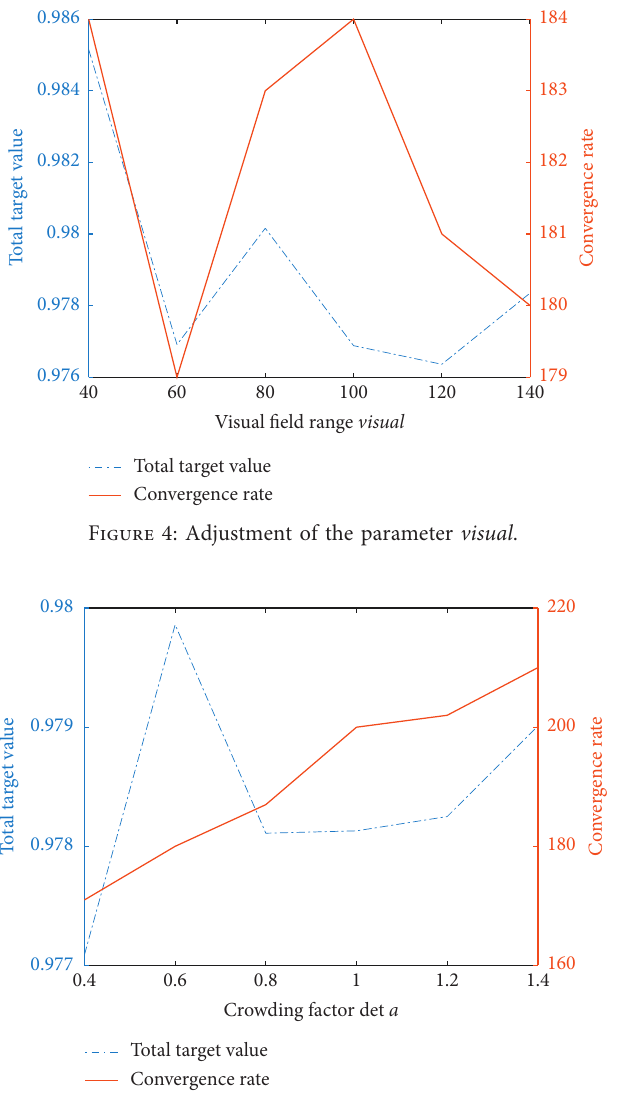
Figure 5: Adjustment of the parameter det a .